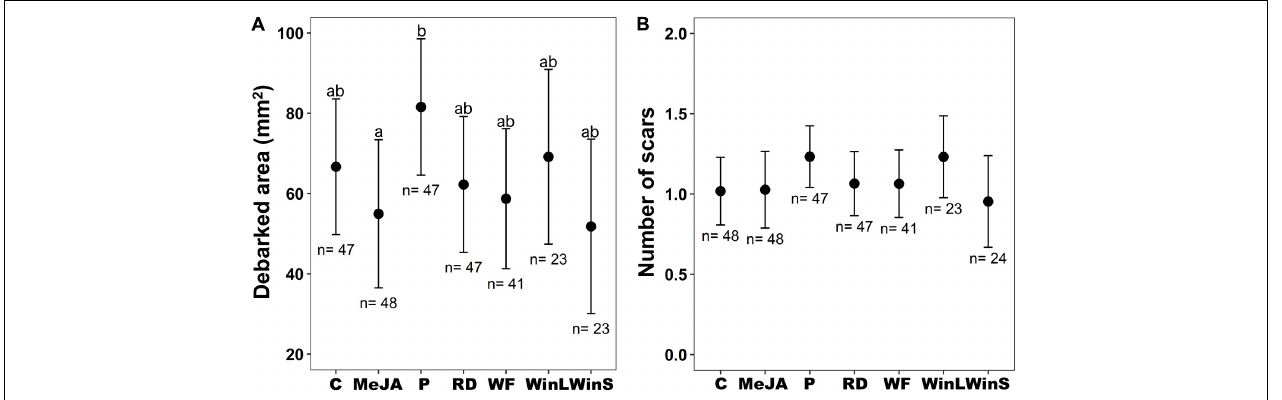
FIGURE 1 | Pine weevil damage to Scots pine ( P. sylvestris ) seedlings in experiment 1 (Insect feeding tests were conducted at one time point, 12 days post-treatment) after receiving different induction treatments [Undamaged seedlings as controls (C), 10 mM MeJA (MeJA), needle-piercing damage to the stem bark (P), root bark damage (RD), previous weevil feeding damage (WF), large stem window damage (WinL), and small stem window damage (WinS)]. (A) Estimated mean debarked area ( ± 95% confidence intervals), and (B) Estimated mean number of feeding scars ( ± 95% confidence intervals) for each treatment. Sample sizes ( n ) used in the statistical analyses are also shown. Different letters above means indicate statistically significant differences ( P < 0.05) between mean